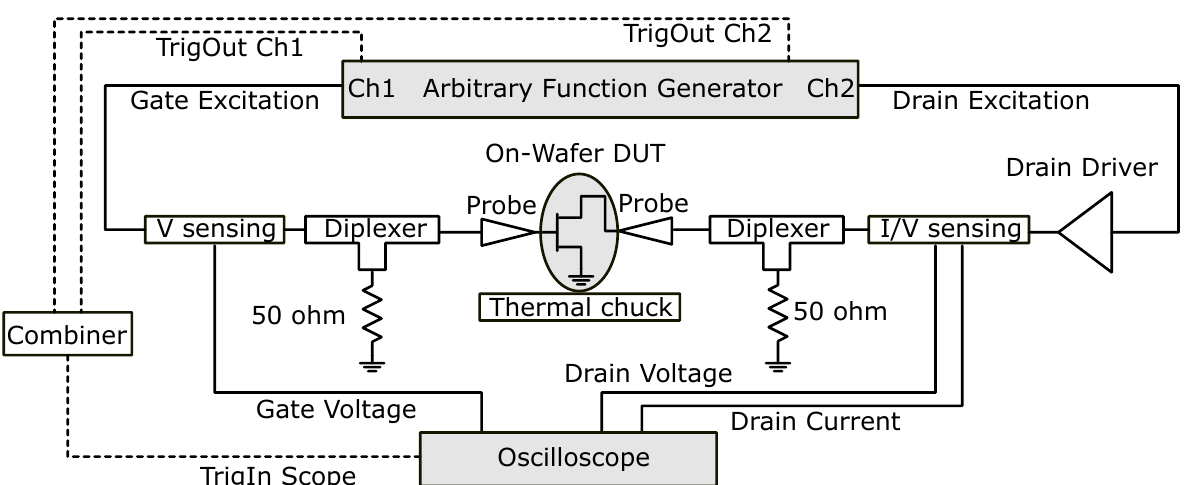
Figure 2. Block diagram of the measurement setup (10-MHz reference not